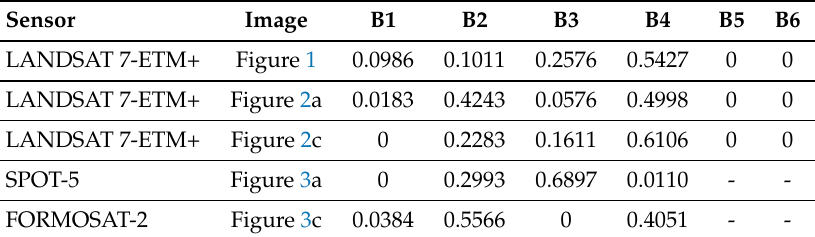
Figure 4. LANDSAT 7-ETM+ band spectral response normalized to one. Table 2. Estimated λ values for the different